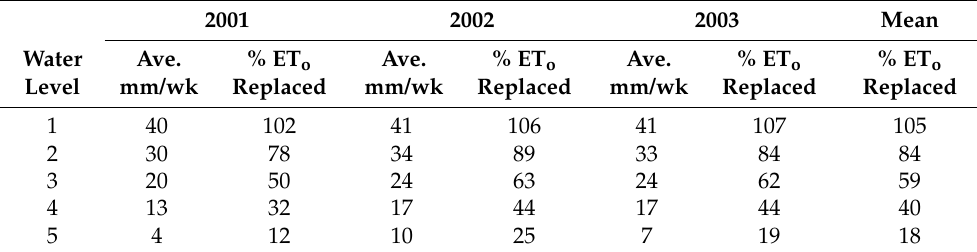
Table 1. The amount of water (irrigation and precipitation) and percent ET o replacement at five water levels in a tall fescue line-source